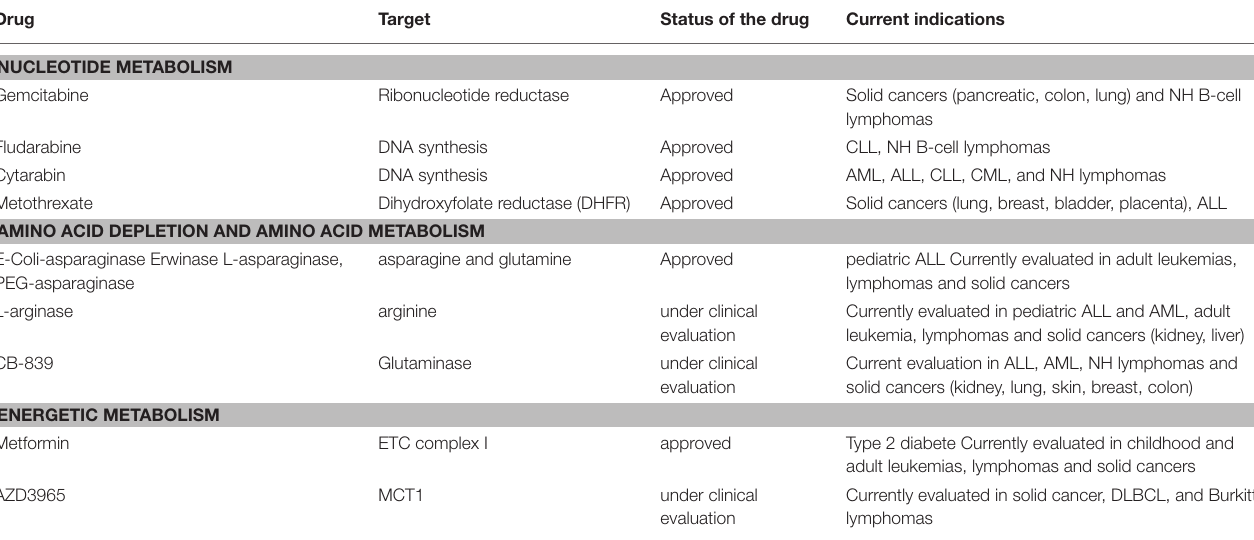
TABLE 3 | Anti-metabolic agents that can be combined with rapalogs to improve cytotoxic